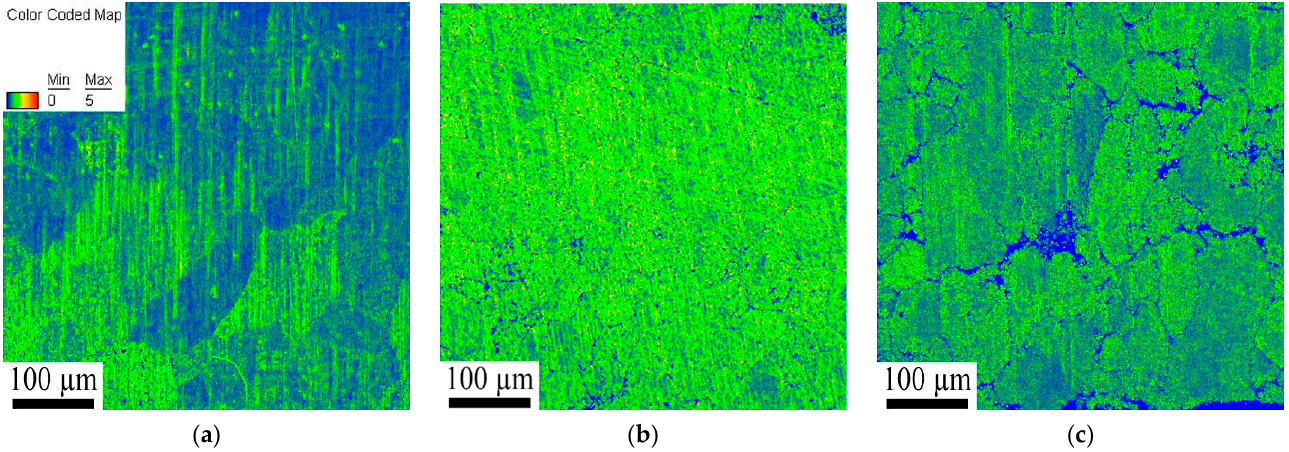
Figure 10. Kernel average misorientation maps of surface layers in ARMCO iron after the fatigue test for the initial ( a ) and LSP treated samples ( b , c ); ( b ) was obtained in the center of specimen and ( c ) was obtained at the surface layer. The bottom edge of the images ( a , c ) corresponds to the surface of the specimen.